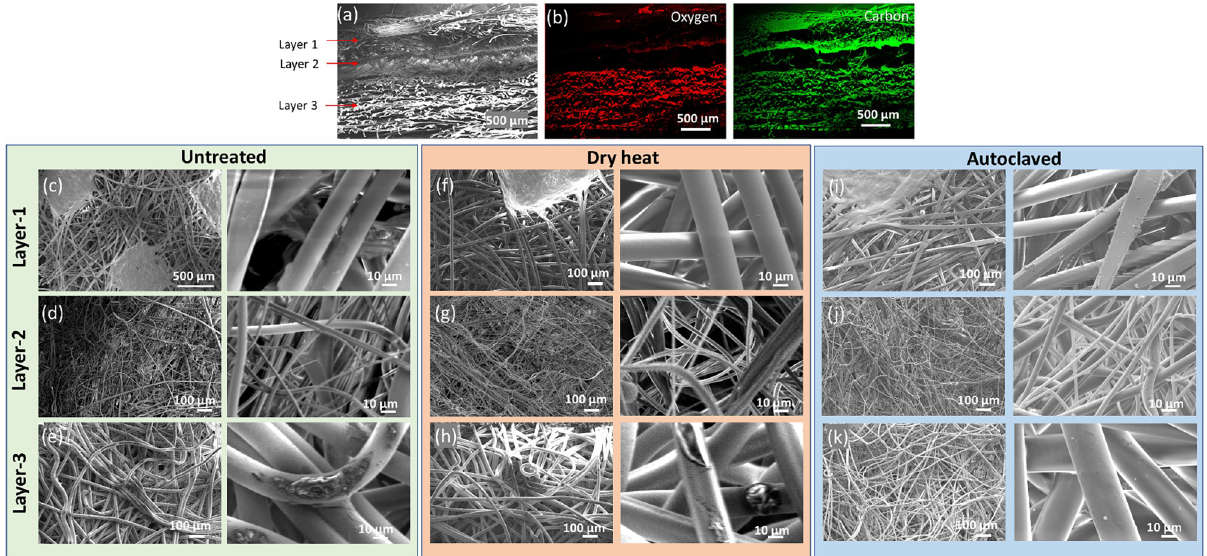
Fig 3. SEM characterizations of three layers in 3M 1860 N95 FFR. ( a-b ) SEM/EDS images of cross section. ( c-e ) SEM images of top-down view of untreated 3M 1860 N95. ( f-h ) SEM images of top-down view of the of 3M 1860 N95 after dry heat treatment at 100˚C for 4 cycles. ( i-k ) SEM images of top-down view of the of 3M 1860 N95 after autoclaving